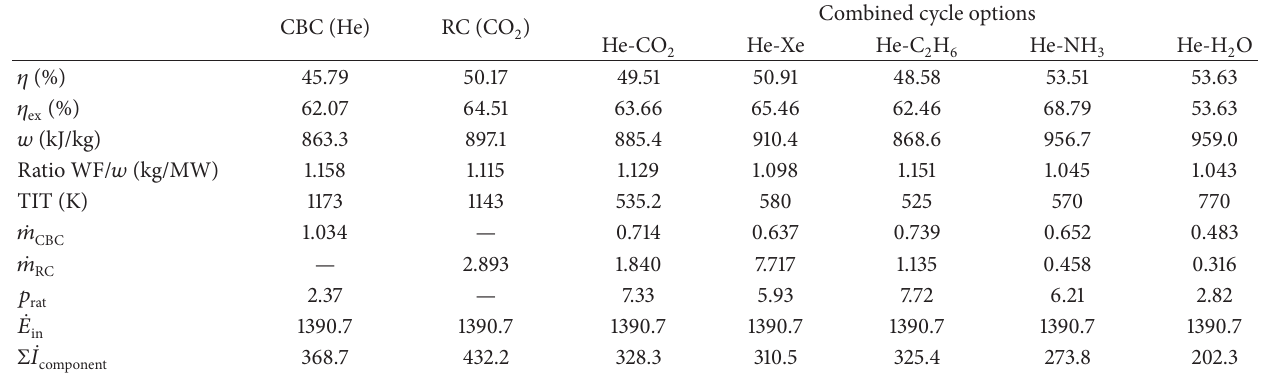
Table 8: Main results achieved from the case study for comparison